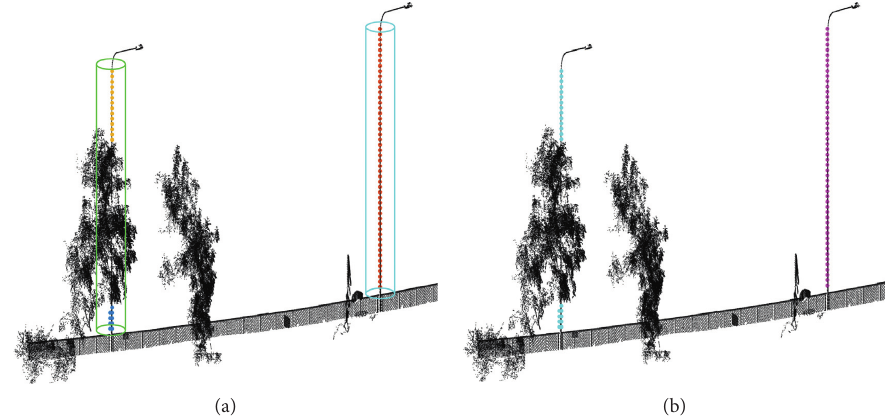
Figure 8: Bottom-up region growing. (a) Bottom-up growing within a horizontal distance constraint for voxels (different voxel clusters are shown by different colors). (b) Voxels belonging to different individual PLOs (different colors denote different pole